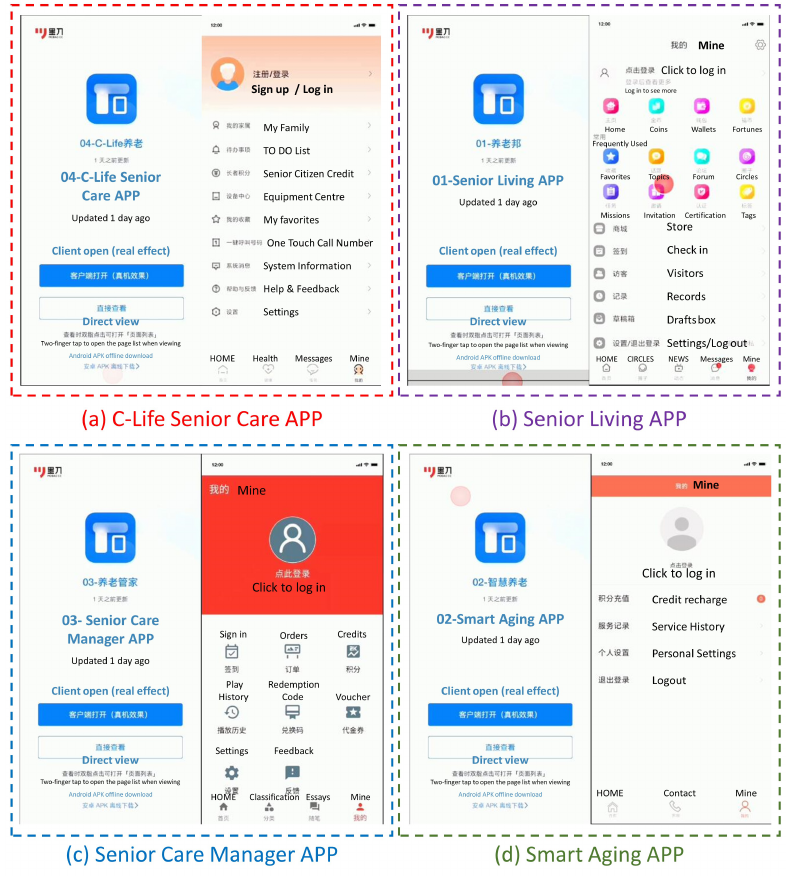
Figure 1. Experimental stimulus material: the login interface of the four